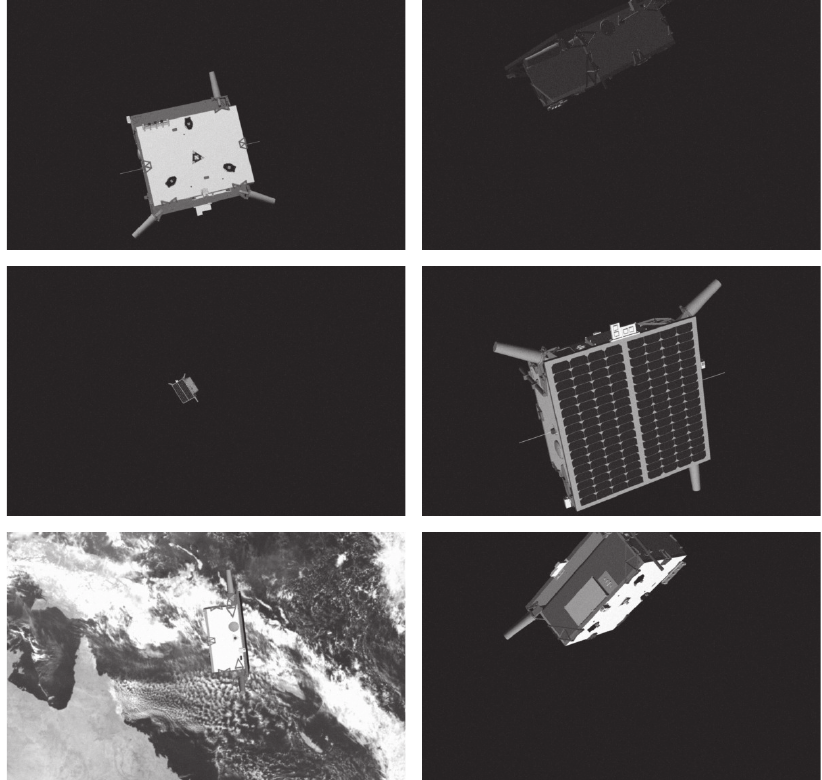
Figure 4. Images with Different Conditions in 12,000 Synthetic Images. They vary in light intensity, relative distance to spacecraft, perspective and background